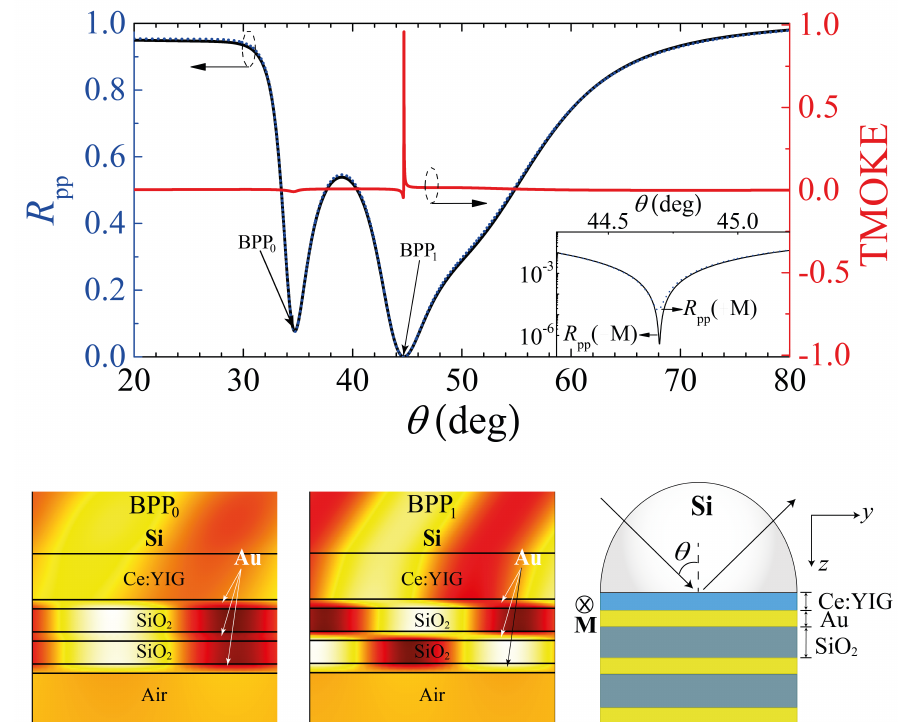
Figure 3. Upper panel: results for the reflectances R pp ( ± M ) and TMOKE are shown for comparison. The inset shows the difference between the R pp (+ M ) and R pp ( − M ) values around the BPP 1 resonant angle (44.69 ◦ ). Lower panel: the magnetic field profiles H x (associated with the BPP 0 and BPP 1 ) and a schematic representation of the proposed MO structure, respectively. All the calculations in this figure were performed using d m = 20.42 nm and d Ce − YIG = 100